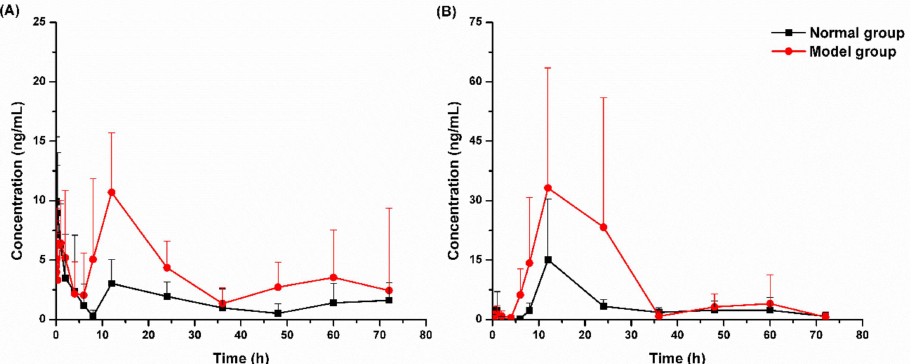
Figure 3. Plasma concentration–time curves of linarin ( A ) and acacetin ( B ) after oral administration of linarin in normal and model rats ( n =